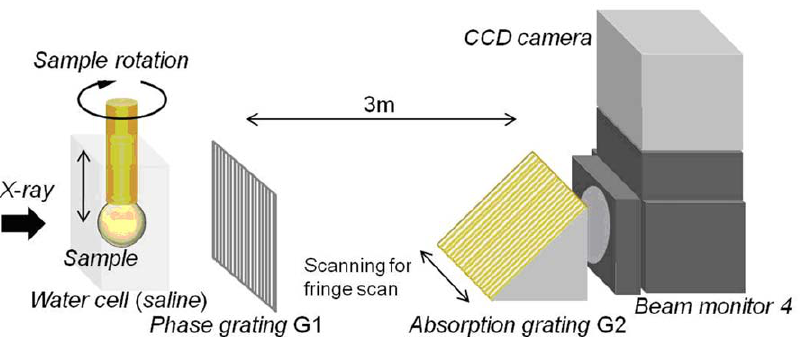
Figure 6. Diagrammatic representation of the X-ray Talbot interferometer showing the sample cell with sample suspended on a rotatable rod; the phase and absorption gratings (G1 and G2 respectively) and the beam monitor.